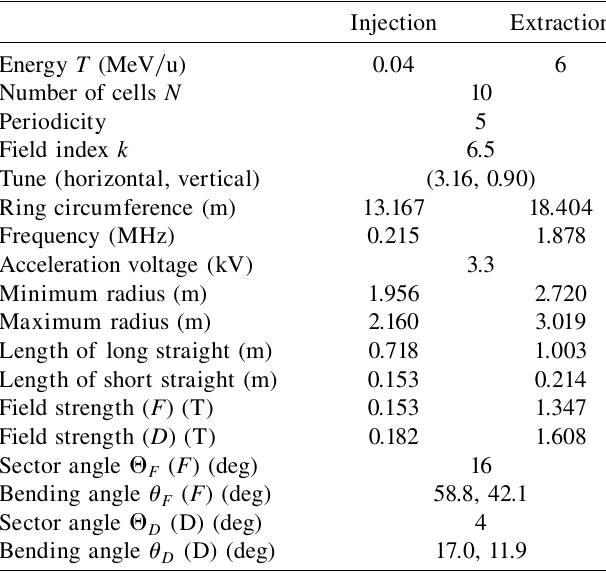
TABLE VI. Basic lattice parameters of the ME-FFAG